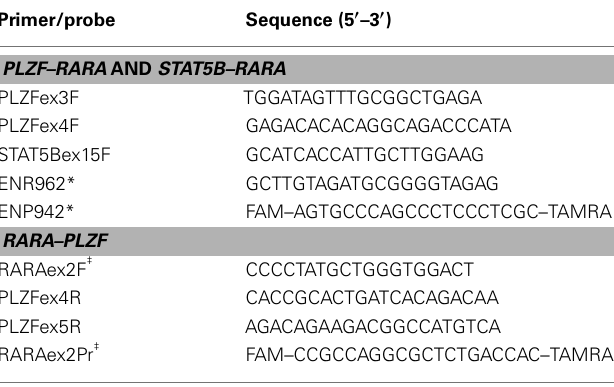
Table 2 | Primers and probes used to detectAPL fusion